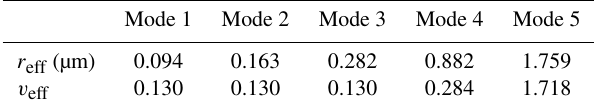
Table 1. Definition of the effective radius ( r eff ) and the effective variance ( v eff ) in the SRON five-mode